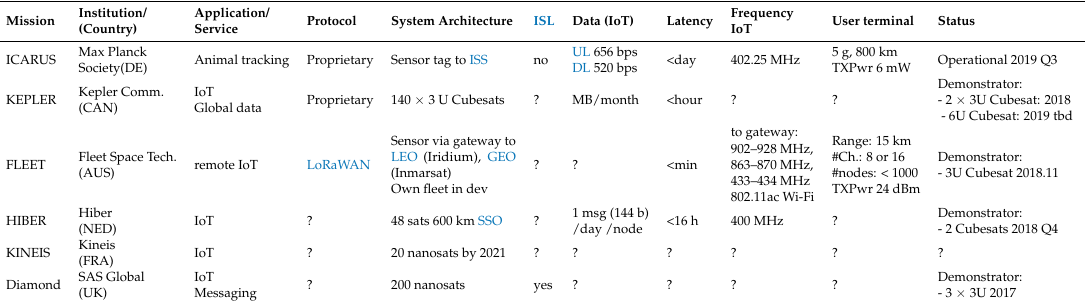
Table 1. List of satellite (constellations) for an IoT/M2M service.